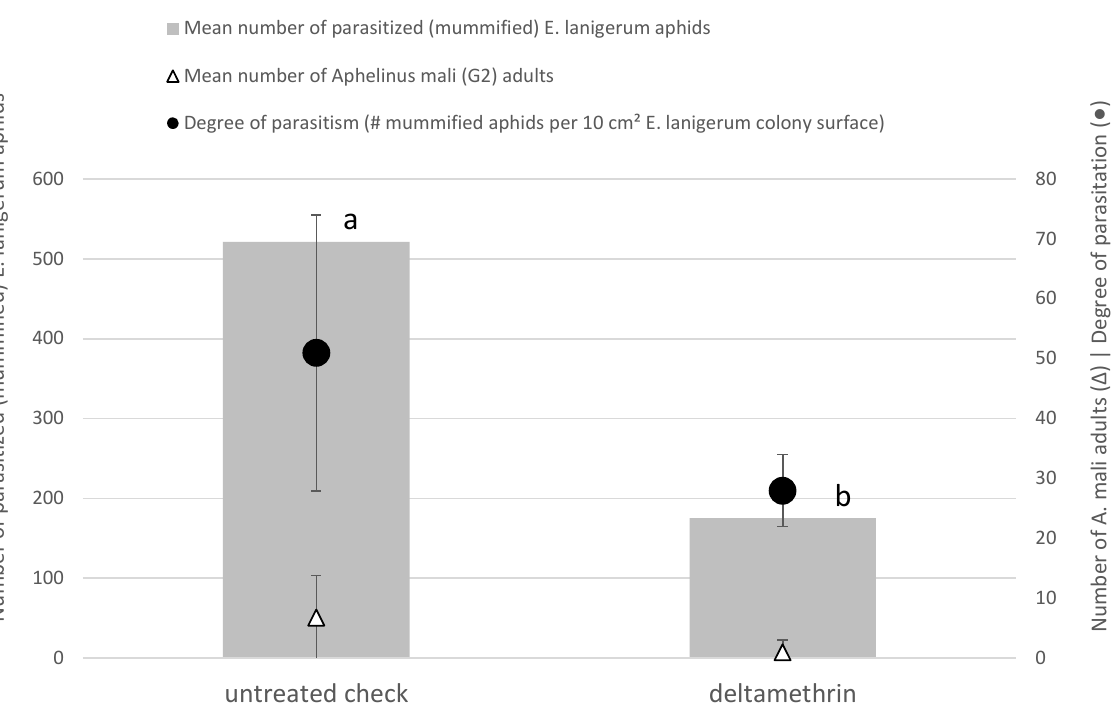
Figure 5. Results of field trial with deltamethrin sprayed at 4.5 g/ha LWA (Leaf Wall Area) on 16/04/2020 during the first flight period of A. mali adults. Assessments on 17/06/2020 of number of parasitized E. lanigerum aphids (grey bars, left vertical Y -axis), number of A. mali (G2) adults (with triangles) and total degree of parasitism (black circles) (both right vertical Y -axis) are shown. Statistical differences are indicated with different letters. Error bars represent the standard errors of counted numbers.